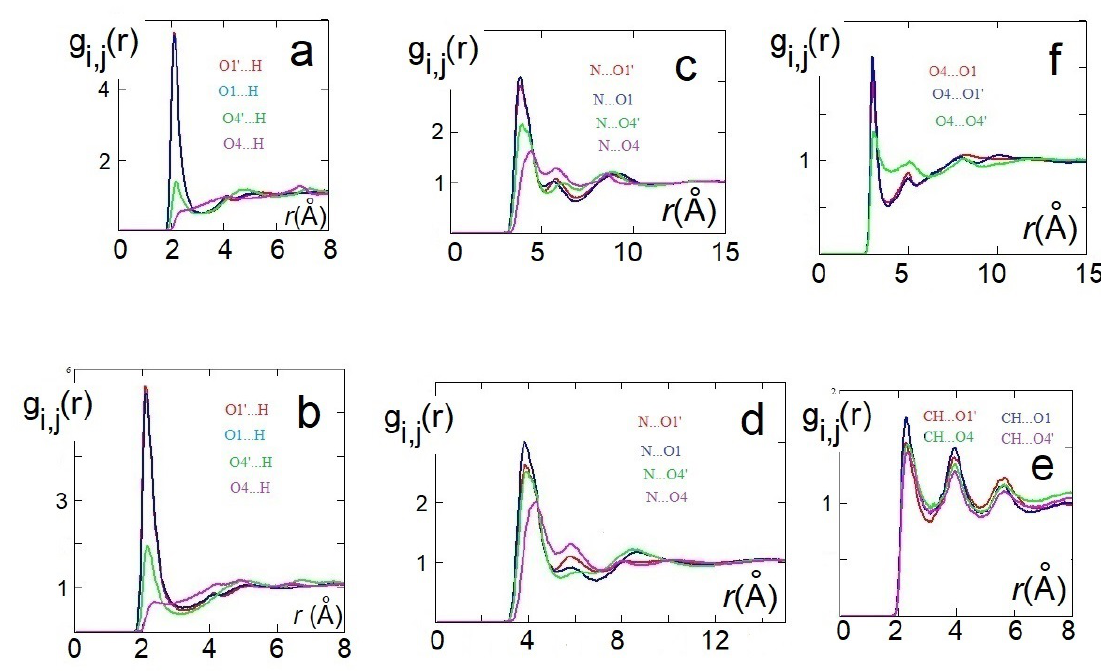
Figure 5. RDFs of the H· · ·O, N· · ·O and CH· · ·O cation anion distances in [Ch][H-fumarate] ( a , c , e ) and [Ch][H-maleate] ( b and d ); RDFs of the O· · ·O anion–anion distance in [Ch][H-fumarate] ( f ) from classical molecular dynamics (MD)